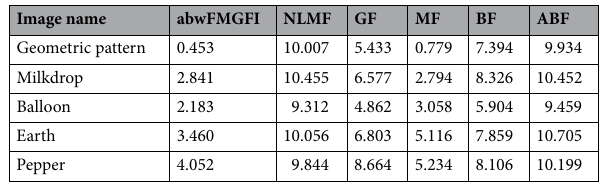
Table 3. Comparison of the RMSE values of each sample image filtered using each filter (against the salt-and- pepper